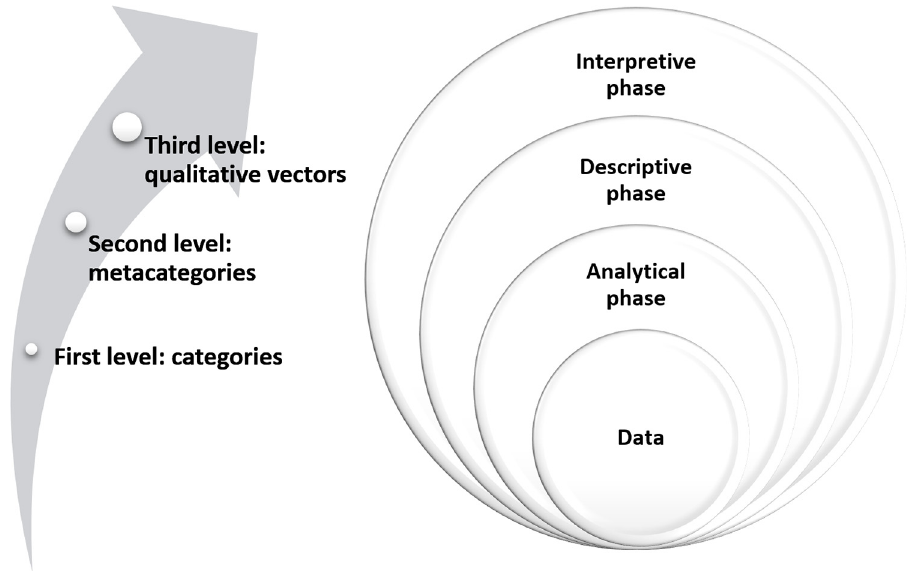
Fig 2. Analytical phase. Open and Axial Coding. Source: Created by the